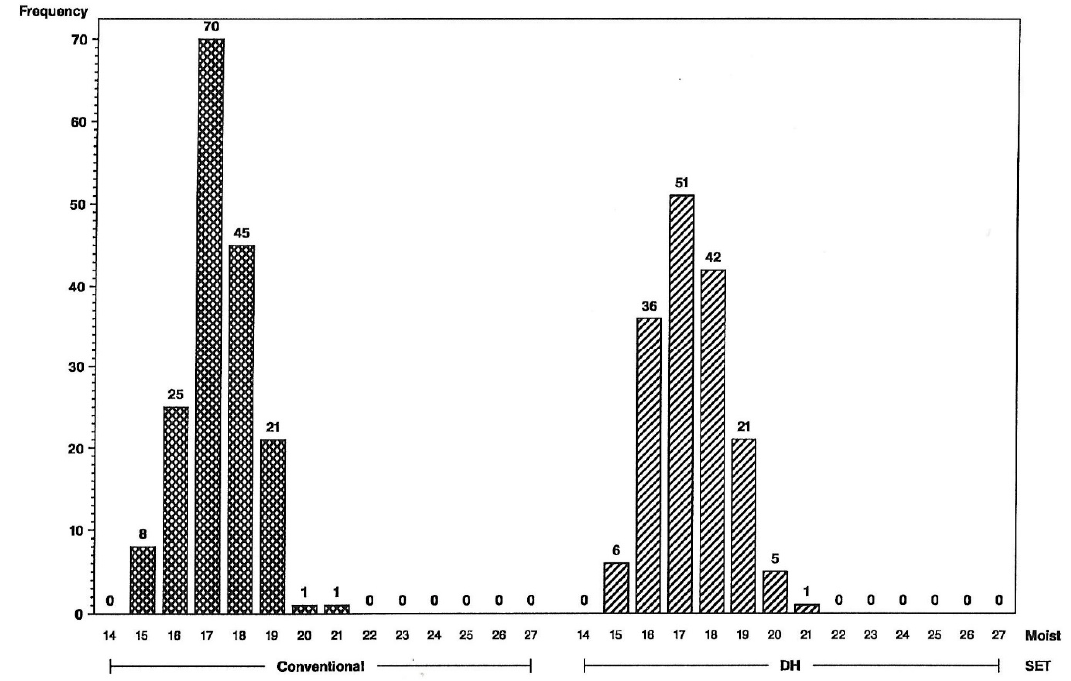
Figure 3. Frequency distributions for maize hybrid grain moisture in percent (on x -axis) using the L inbred tester, conventional S2 line-hybrids on the left and DH line-hybrids on the right. Numbers of hybrids are above the bars.